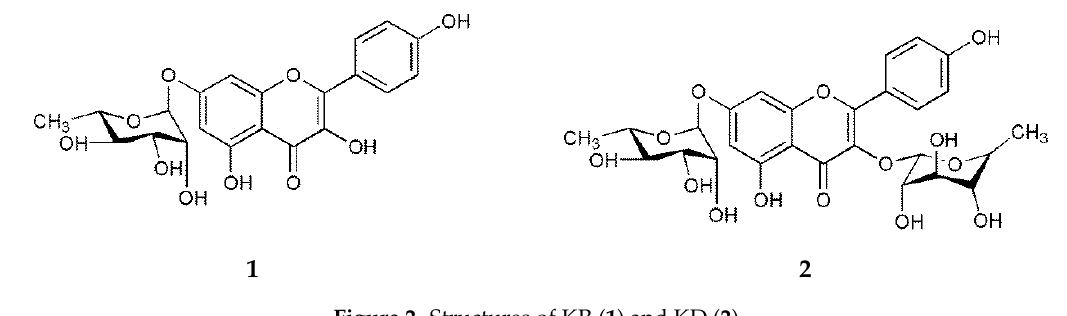
Figure 2. Structures of KR ( 1 ) and KD ( 2 ).